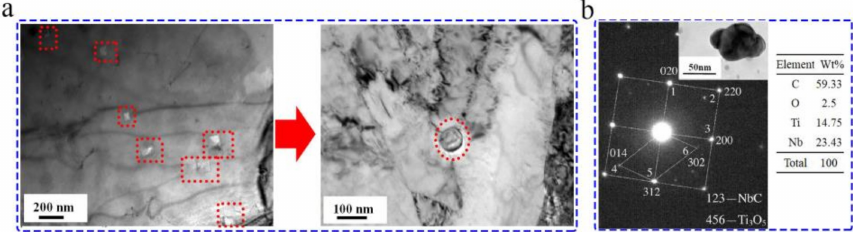
Figure 15. ( a ) TEM micrograph and EDS result of inclusions in the investigated plain carbon steel with and without in-situ nanoparticles [56], ( b ) TEM and EDS analysis of the composite nano-precipitated phase in Ni-Cr-Mo HSLA steel